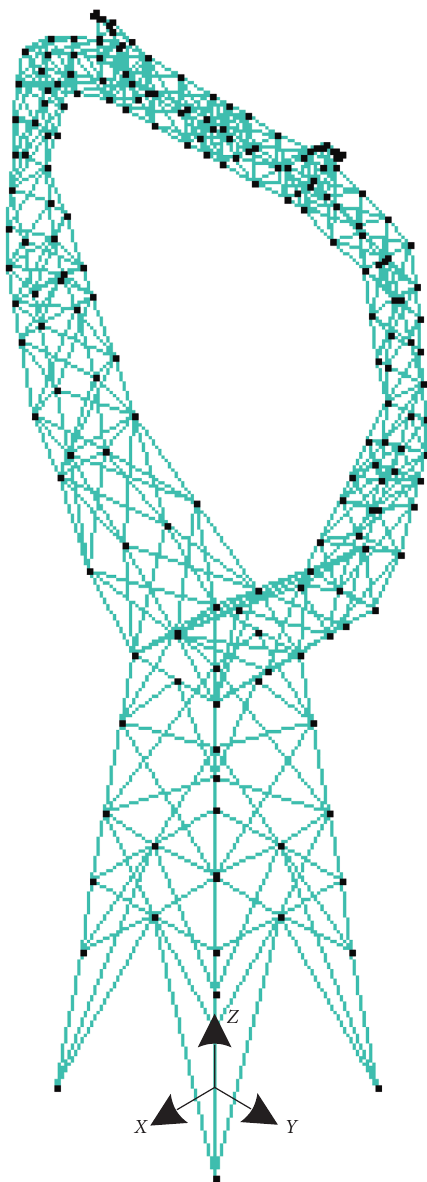
Figure 3: The finite element model of the transmission